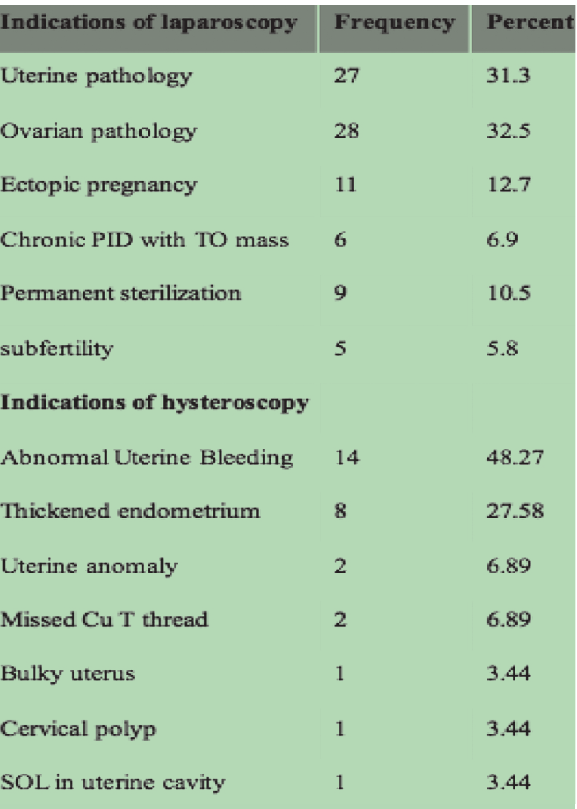
Table 2: Indications of Minimally invasive